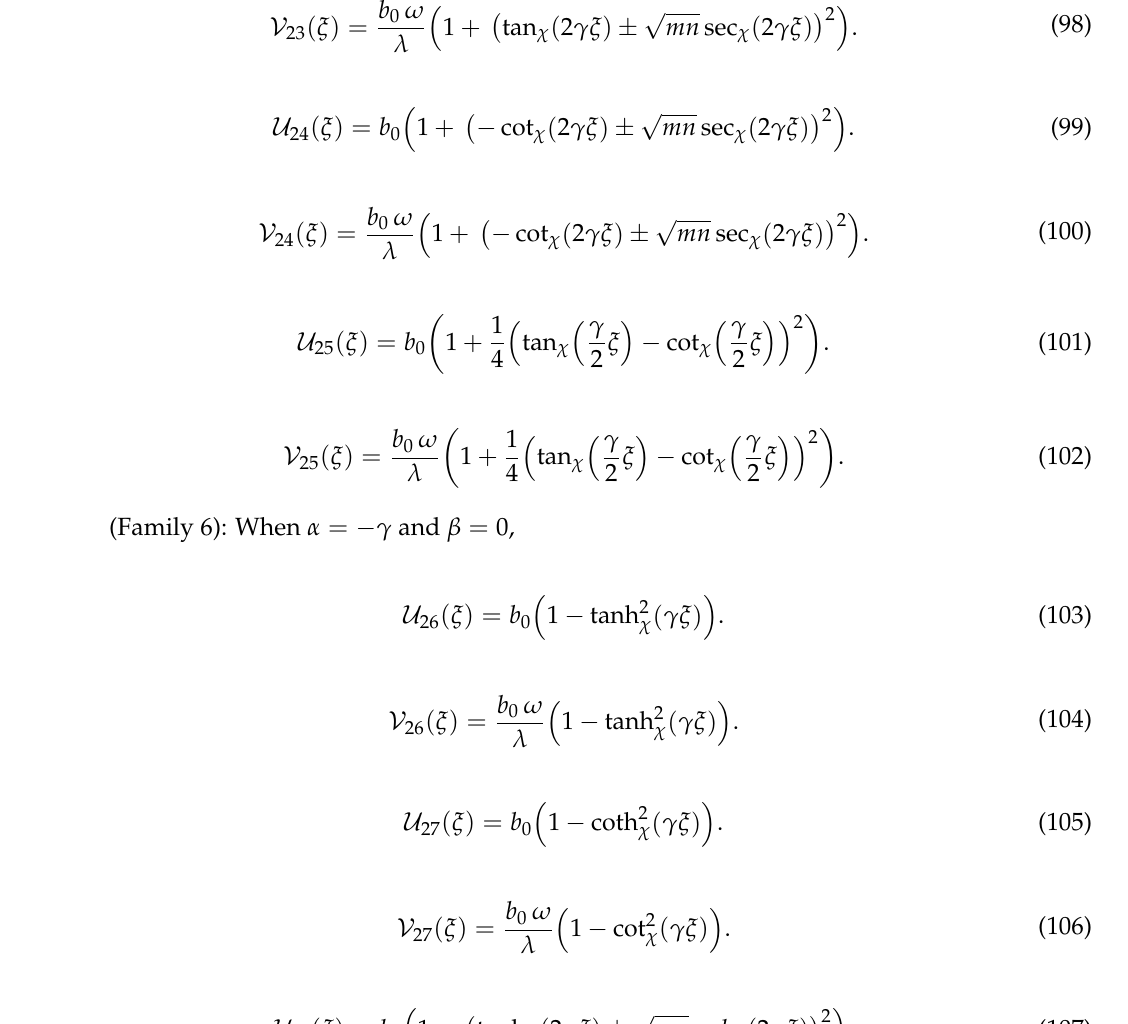
(Family 6): When α = − γ and β =